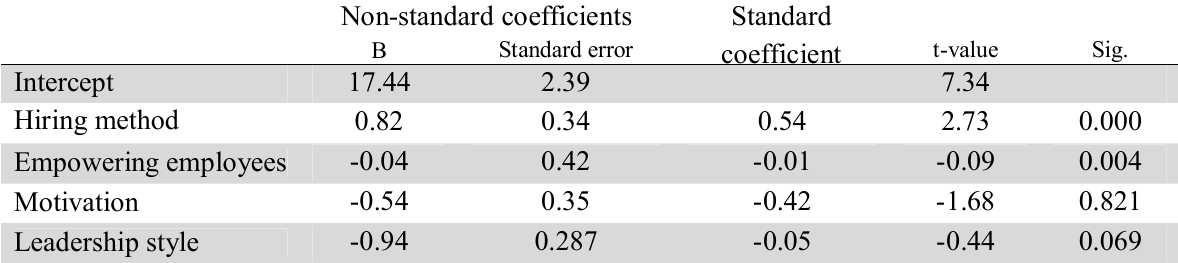
The results of regression analysis Non-standard